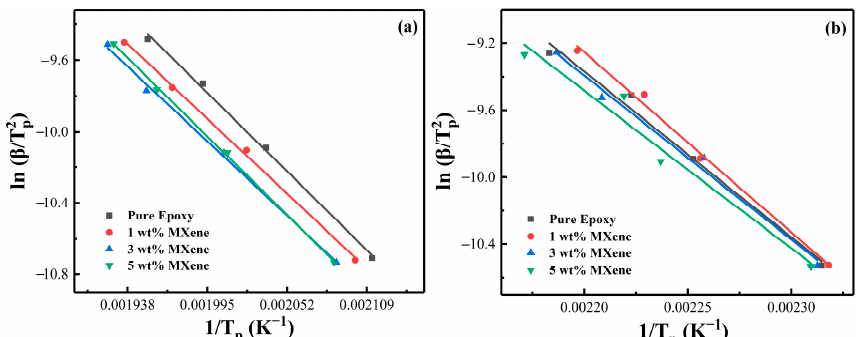
Figure 5. The linear fitting via FWO method with different MXene content: ( a ) PNE-177/DDS and ( b ) PNE-177/DICY.